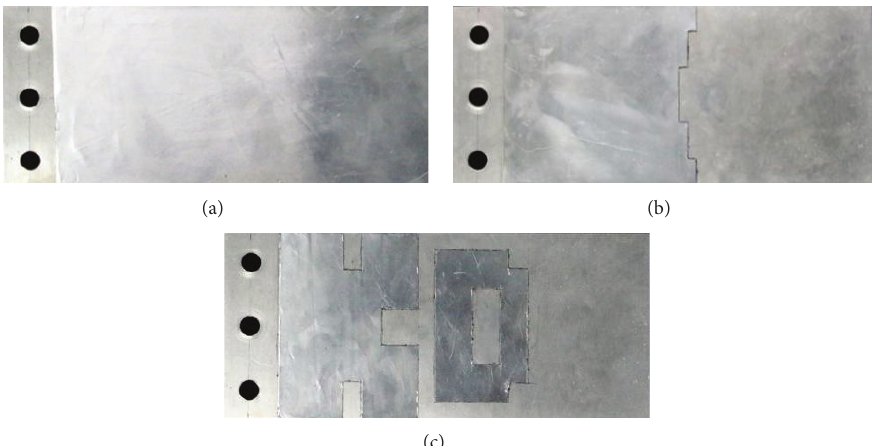
Figure 15: The experimental samples. (a) Full coverage. (b) The optimal layout by using conventional sensitivity analysis. (c) The optimal layout by using improved sensitivity analysis.